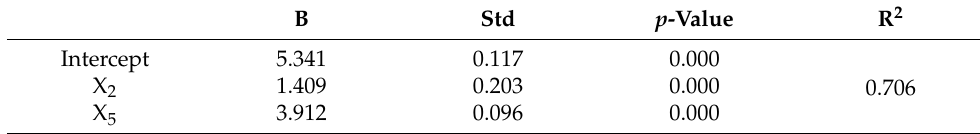
Table 6. MLR model